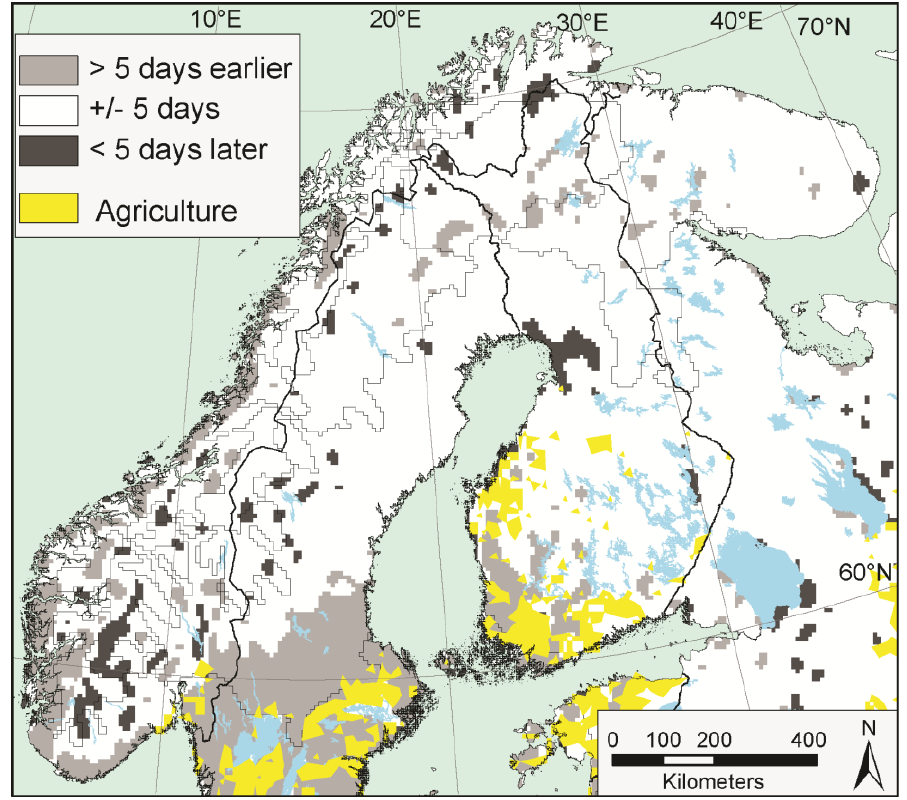
Figure 2. Comparing mean onset of the growing season for the 1982–2006 period based on the NDVI3g and the NDVIg shown in Karlsen et al . [10]. Map shows the day number based on NDVI3g minus the day number based on NDVIg. Yellow areas are agricultural land, while lakes are presented in blue. Black line, national borders; grey line, vegetation region borders (see Figure